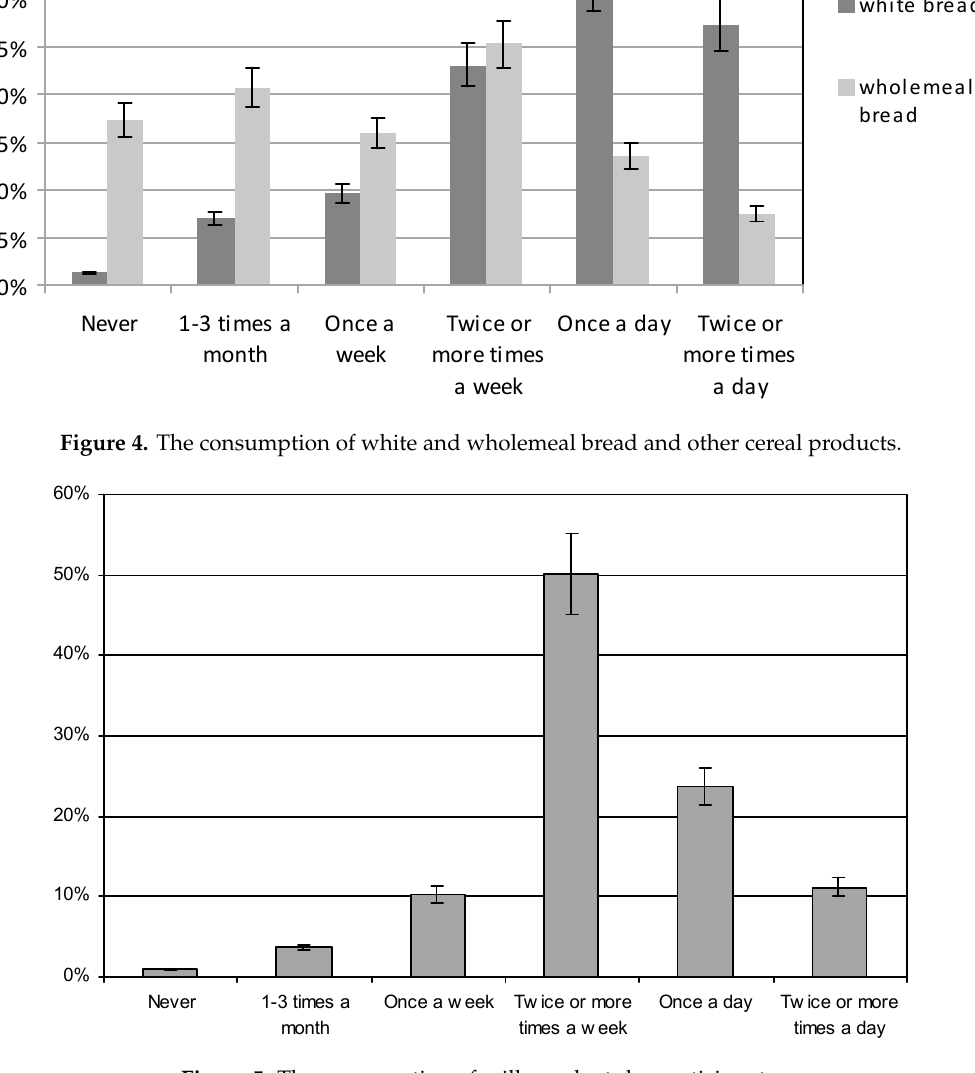
Figure 5. The consumption of milk products by participants.